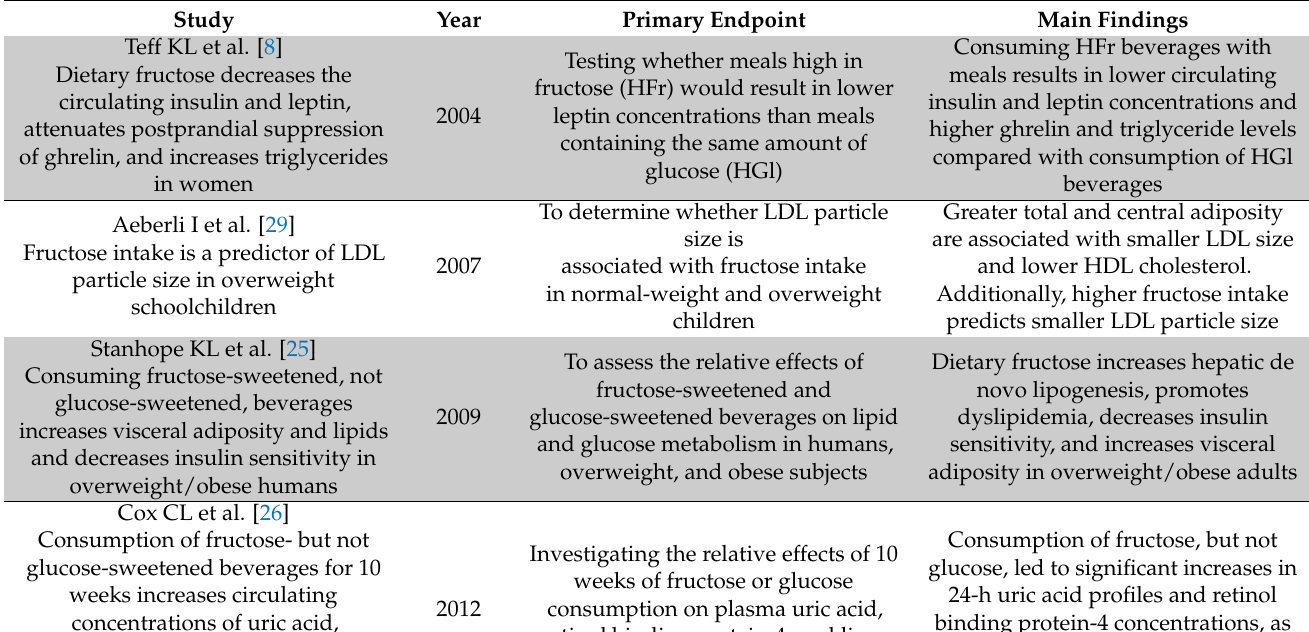
Table 1. Preclinical and clinical studies evaluating fructose consumption on cardiometabolic parame-